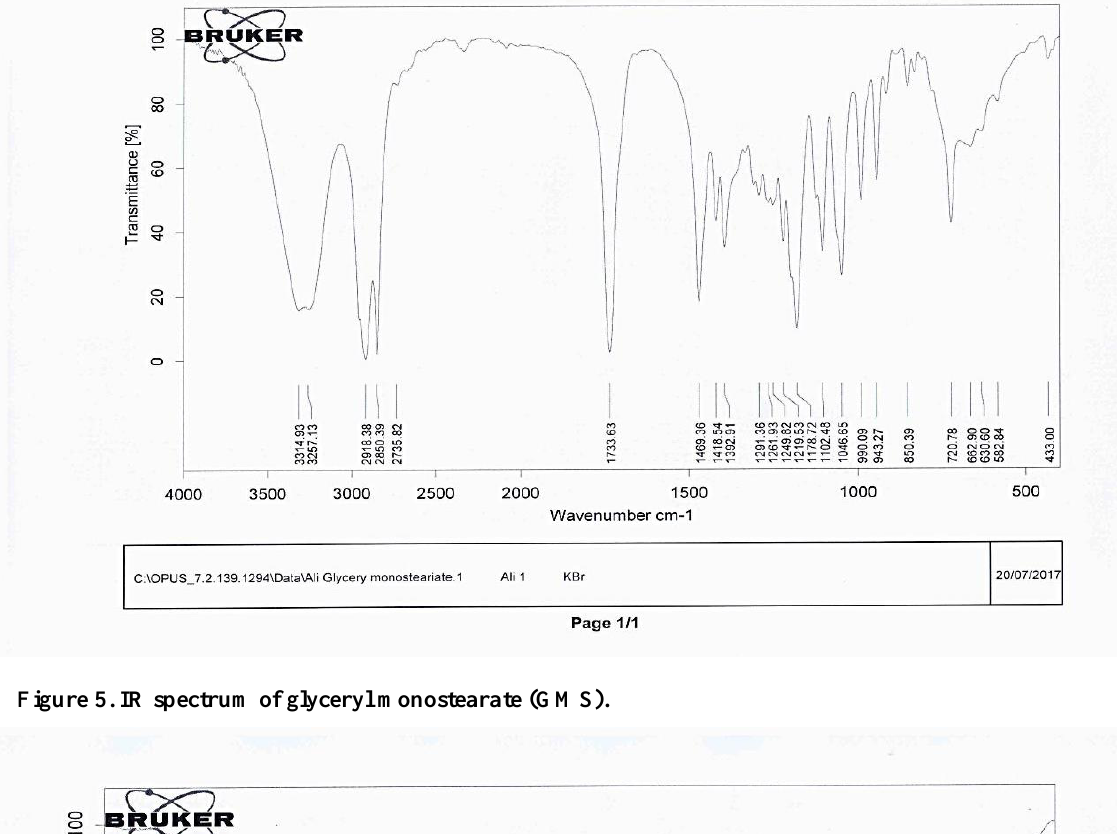
Figure 5. IR spectrum of glyceryl monostearate (GMS).